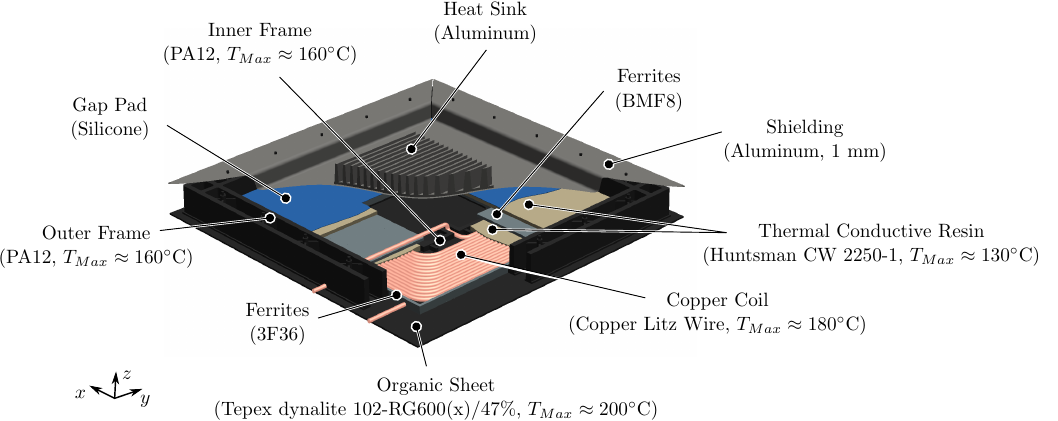
Figure 6. Space–frame concept and maximum temperature ratings of the